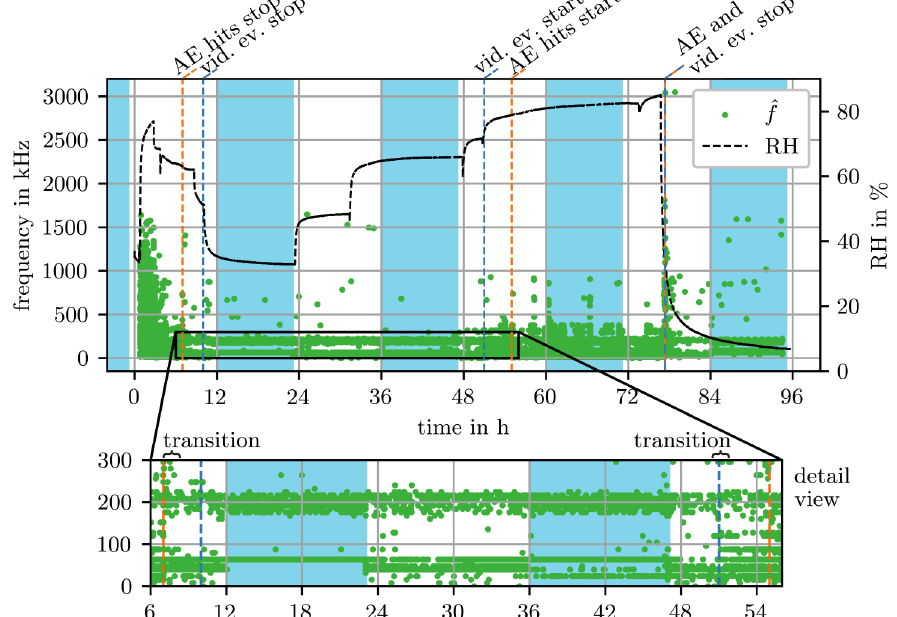
Figure 9. RH and results of the STFT-based frequency analysis of the entire AE data of the atmospheric corrosion experiment. The colored vertical dashed lines represent the times at which the cumulative AE hit energy and cumulative video event count indicate the stopping and starting of the corrosion activity. The areas marked in blue represent the night times from 8pm to 7am. The detailed view highlights the different frequencies at the day and night times, as well as the transitions between frequencies indicating the corrosion activity and constant frequencies due to background